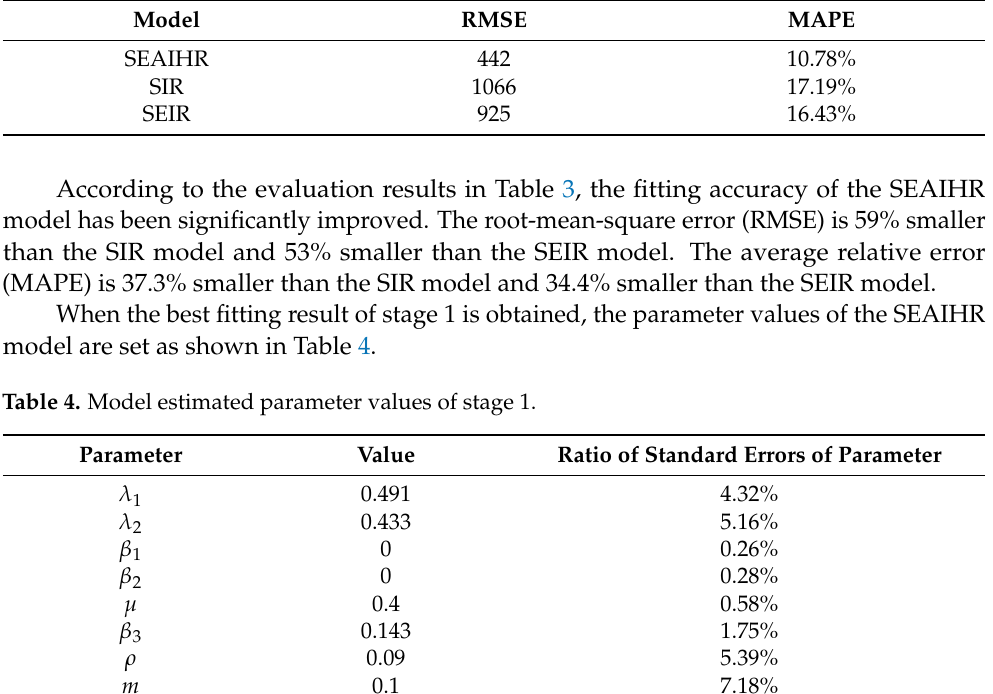
Table 3. Model evaluation in stage 1.